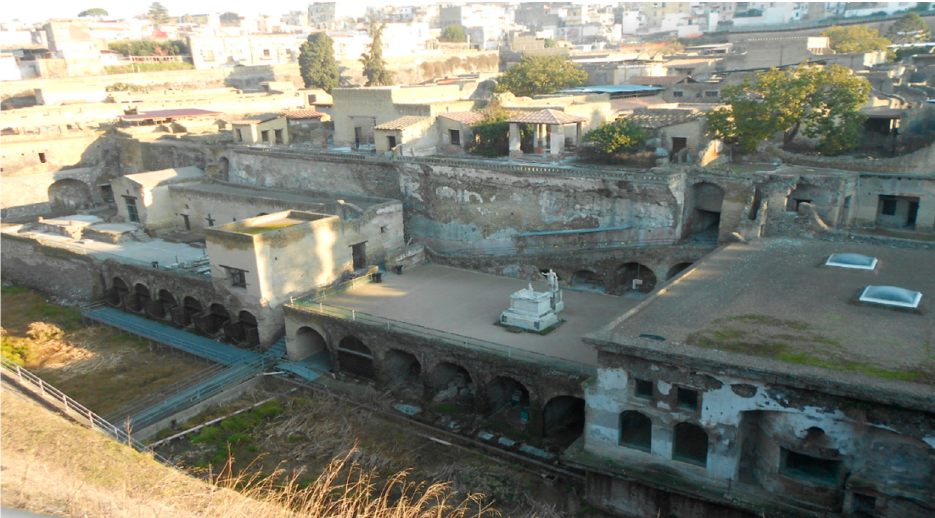
Figure 2. Example of outdoor archeological area. Remains of the antique Roman town of Ercolano (Naples, Italy). In general, outdoor environmental parameters such as sun irradiation, rain, raising humidity, wind, etc. can only be partially controlled due to the different exposition and the extension of the area. Indirect methods aim to keep environmental parameters in a range of acceptability.